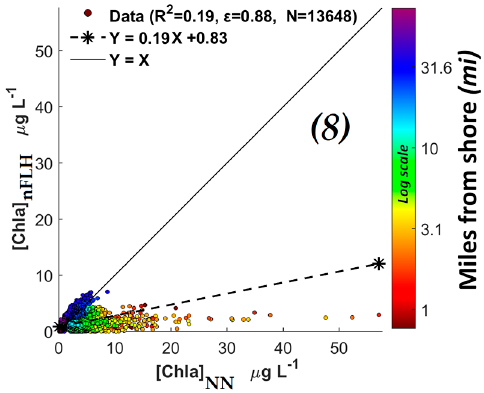
Figure 8. Retrieved MODIS-A nFLH [ Chla ] against retrieved MODIS-A NN [ Chla ], not restricted to open ocean area A, and includes in-shore areas. Color coding of the dots denotes distance to shore, with red being the closest. Note that color bar is in log scale.